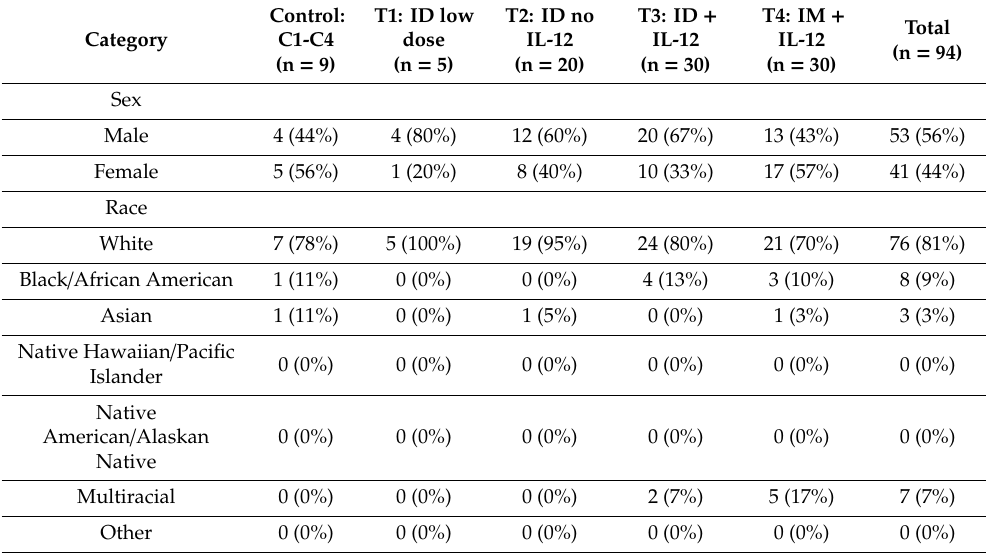
Table 1. HVTN 098 study population demographics and vaccination